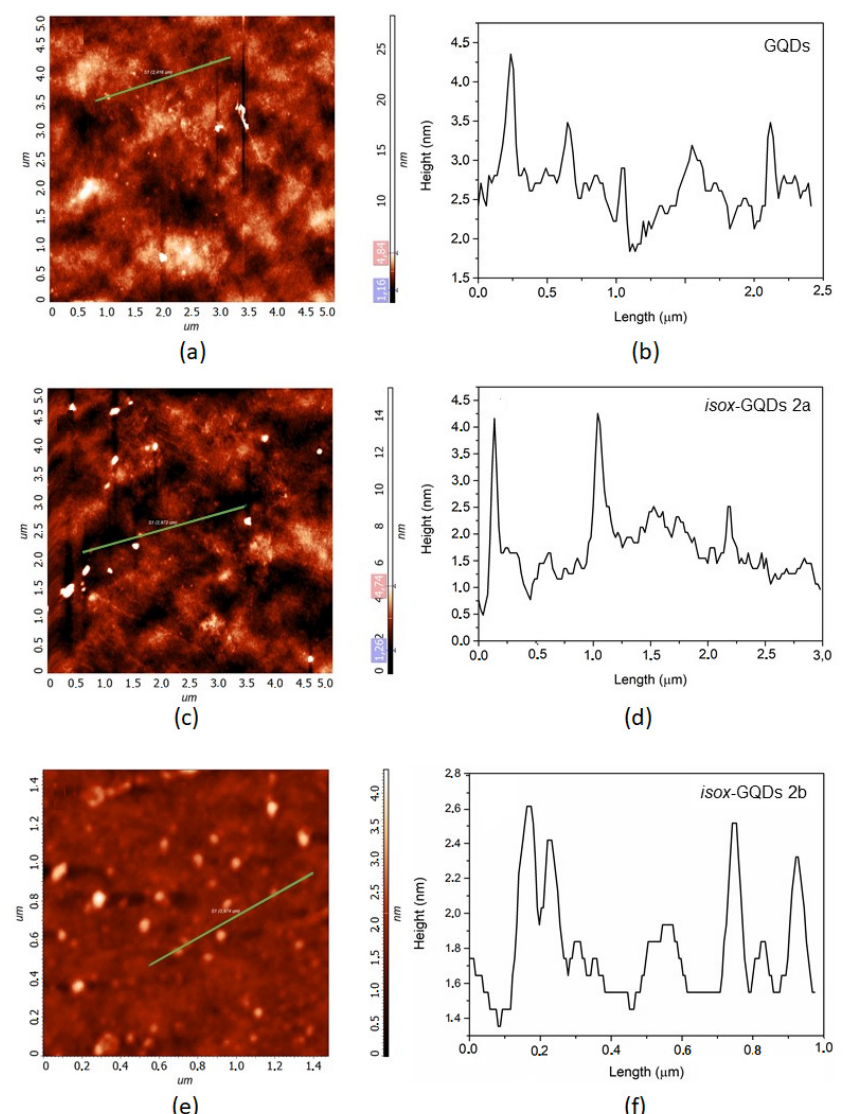
Figure 7. ( a ) Atomic force microscopy (AFM) image of the GQDs deposited on the Si substrate and ( b ) line profile referring to the green line in figure ( a ); ( c ) AFM image of isox -GQDs 2a deposited on the Si substrate and ( d ) line profile referring to the green line in ( c ); ( e ) AFM image of isox -GQDs 2b deposited on the Si substrate and ( f ) line profile referring to the green line in ( e